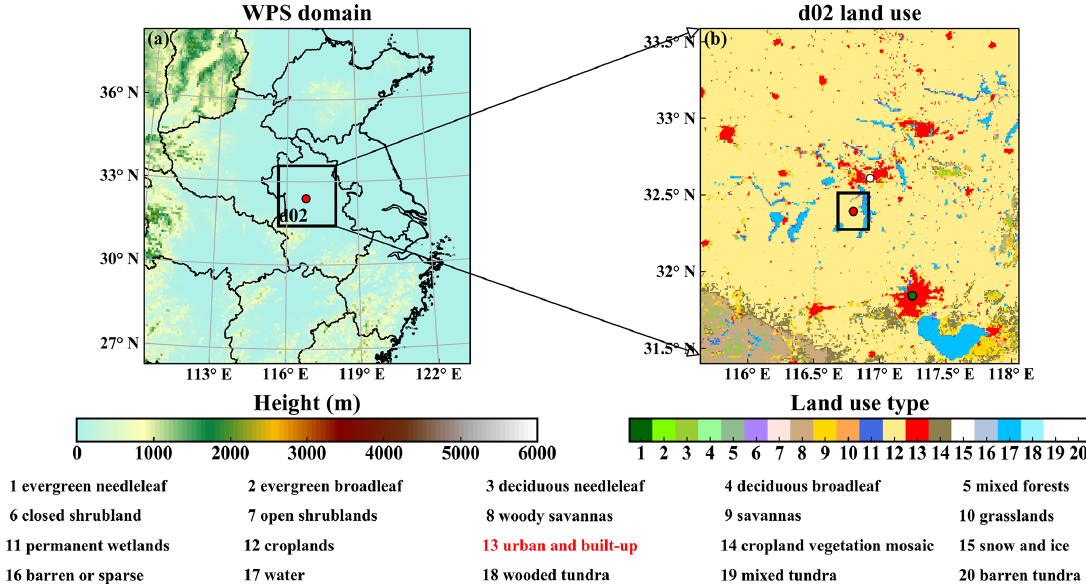
Figure 1. (a) The WRF domain overlaid with terrain height. (b) The land use distribution of domain d02. The green dot is Hefei, the capital of Anhui Province. The white dot is Huainan. The two red dots are the SX site. The land use and emissions of the 22km × 26km black box in the centre of (b) will be altered in the sensitivity experiments.